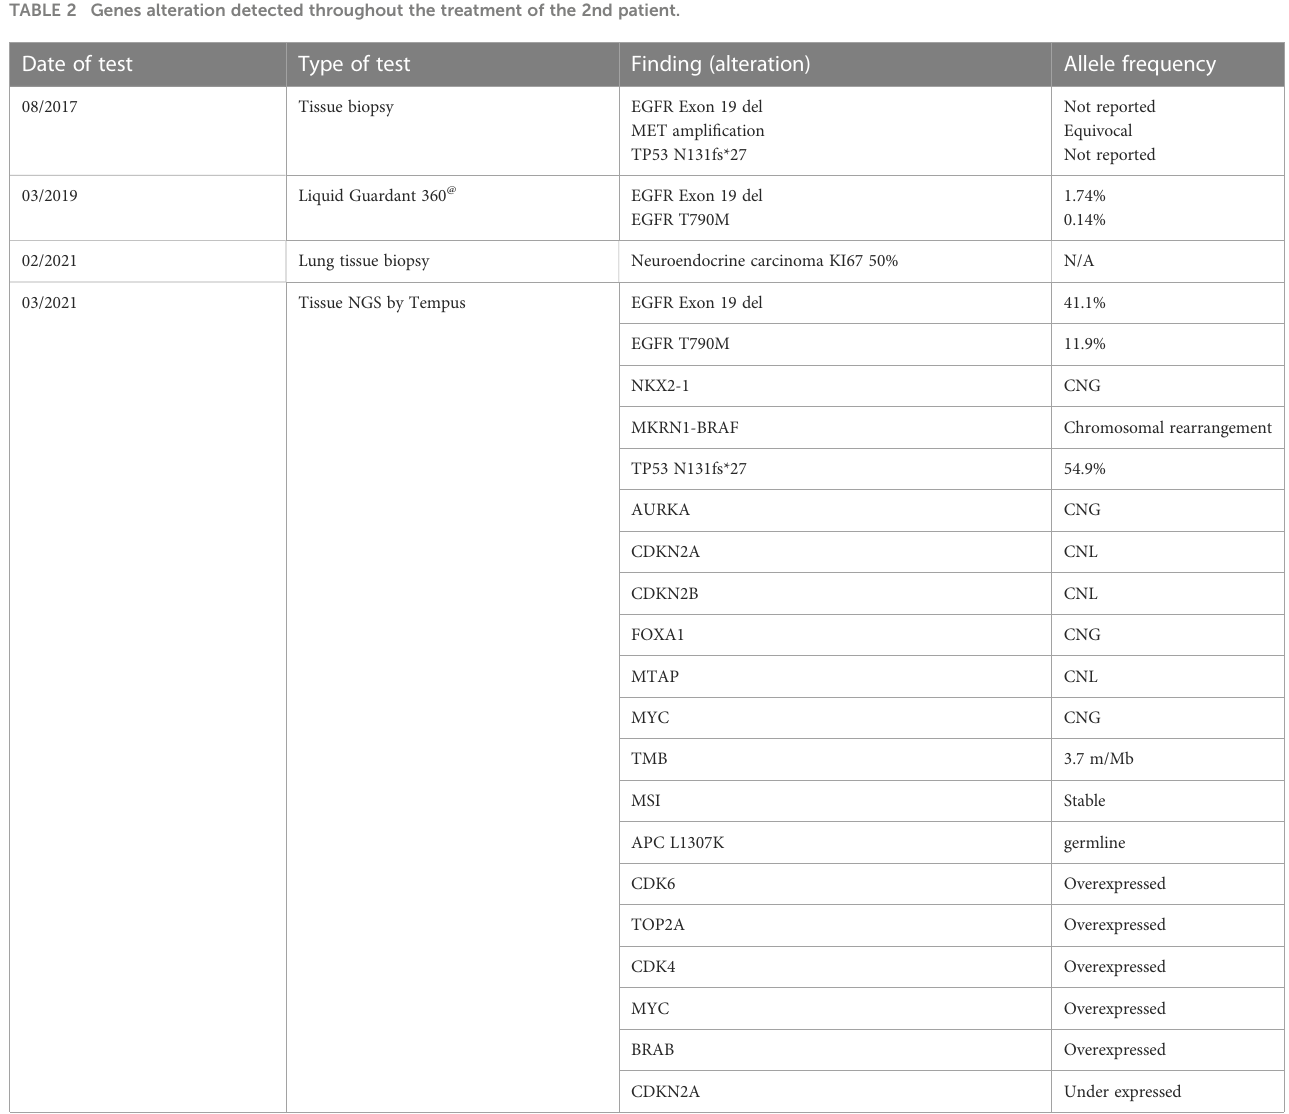
EGFR, epidermal growth factor receptor; MET, mesenchymal epithelial transition; TMB, Tumor mutation burden; MSI, Microsatellite instability; NGS, next generation sequencing; CNL, copy number loss; CNG, copy number gain; N/A, not applicable. These symbols “ * ” and "@" was reported in test